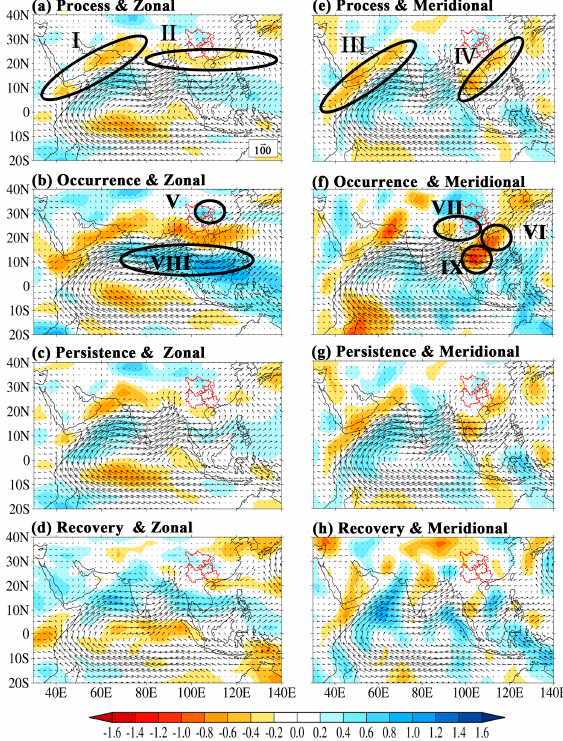
Figure 5. Composites of vertically integrated water vapor transport (WVT) and their zonal standardized anomalies (SA) for drought: ( a ) processes; ( b ) occurrence; ( c ) persistence; and ( d ) recovery phases; and ( e – h ) the same as ( a – d ), respectively, but for meridional SA. Vectors represent vertically integrated WVT, whereas shadows represent zonal or meridional SA. The unit of WVT is kg·m − 1 ·s − 1 . The northward and eastward direction of transport is positive.